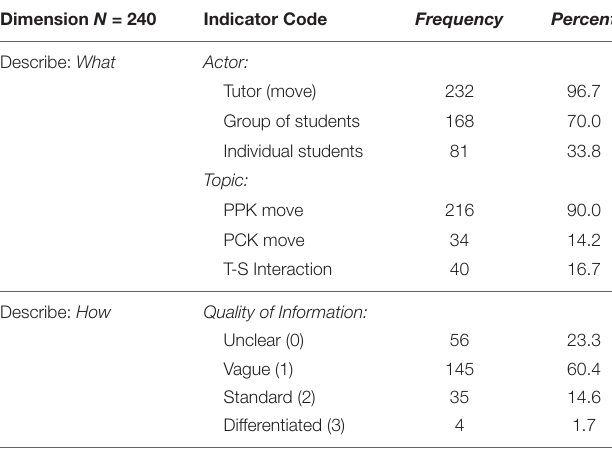
TABLE 4 | Overall frequencies of describing PV skill content and quality indicators.